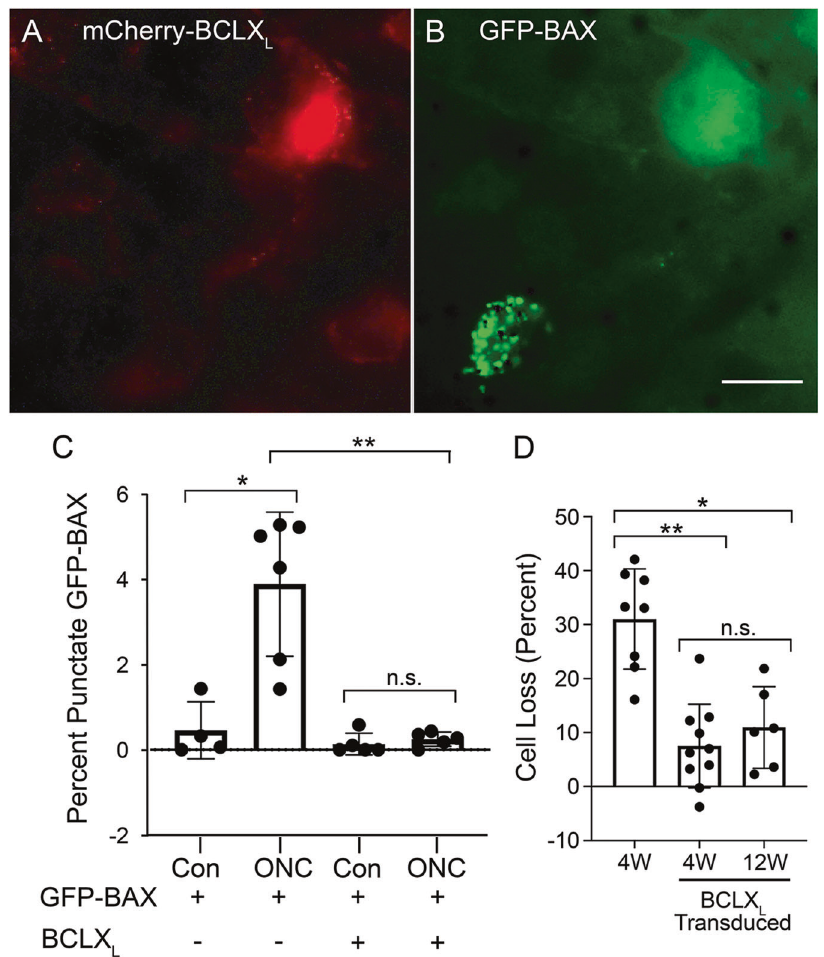
L and GFP-BAX expression, respectively, in a retinal whole mount from a mouse that that had undergone ONC to induce BAX activation. The cell expressing mCherry-BCLX L shows diffuse localization of GFP-BAX and the cell that is not expressing mCherry-BCLX L has punctate, translocated GFP-BAX. Scale bar = 10 µm. C A quanti fi cation of the phenomenon displayed in A , B . In this experiment, all mice were transduced with AAV2-Pgk-GFP-BAX . Half the mice also received an injection of AAV2-Pgk-mCherry-BCLX L . The percentage of